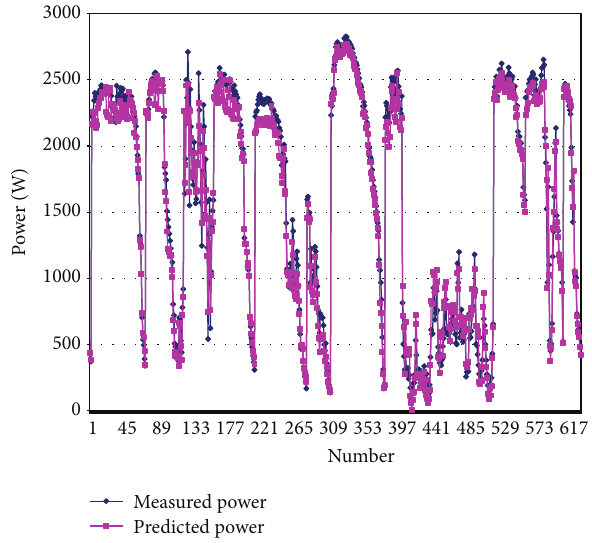
Figure 9: Output power prediction for Model #2, which selects sunny and cloudy data